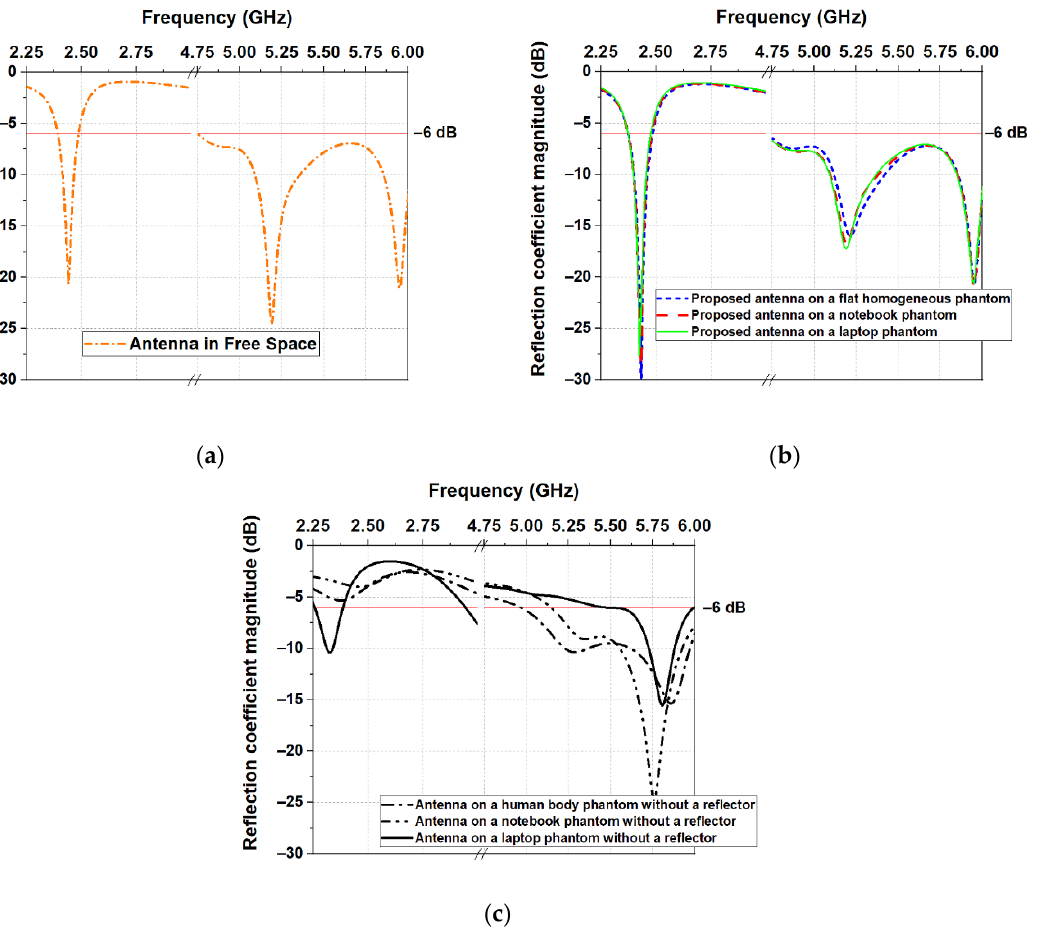
Figure 4. Simulated reflection coefficient |S 11 | of the proposed antenna: ( a ) in free space; ( b ) on a model of a human body, notebook, and laptop; ( c ) antenna without a reflector on a model of a human body, notebook, and laptop.